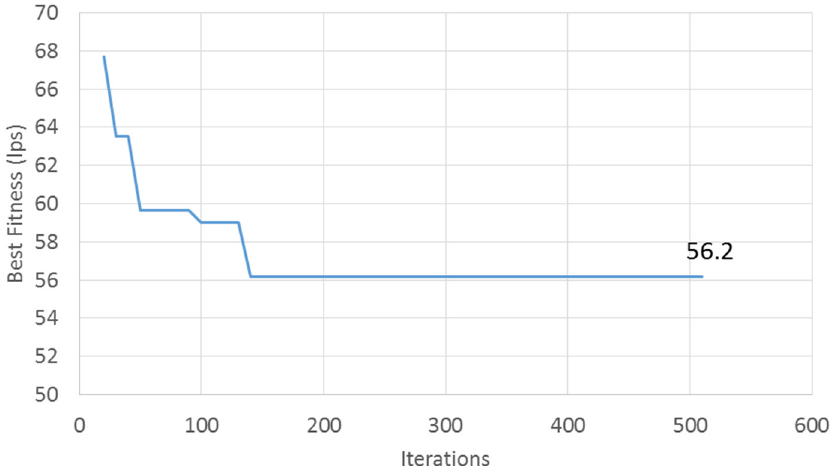
Figure 7. Trajectory of the fitness value of the best solution.